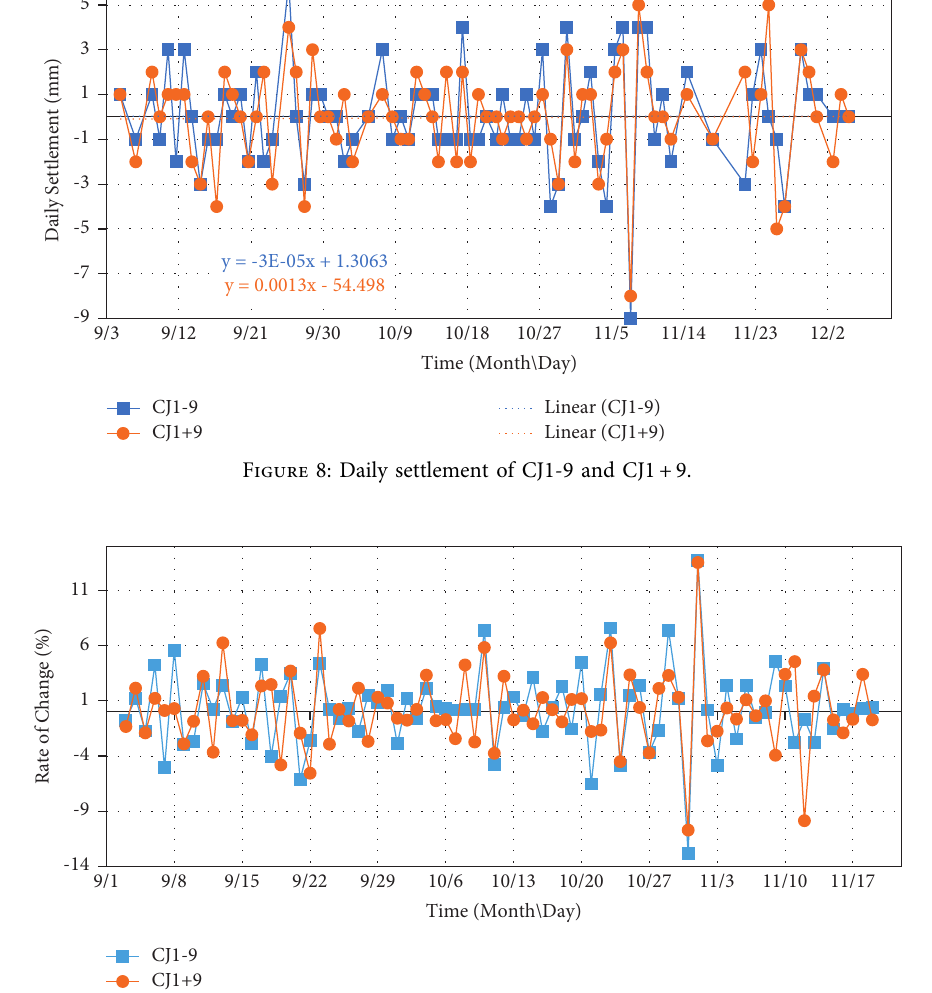
Figure 9: Rate of change of daily settlement (CJ1-9 and CJ1